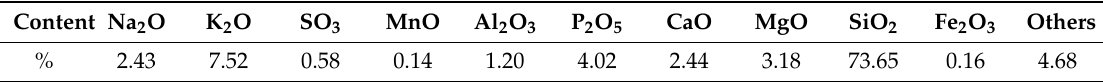
Table 2. The ash content of rice